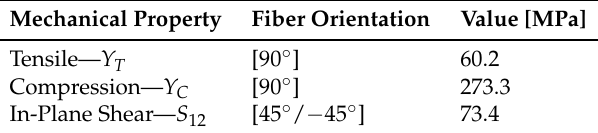
Table 8. Experimental data for AS4-3501